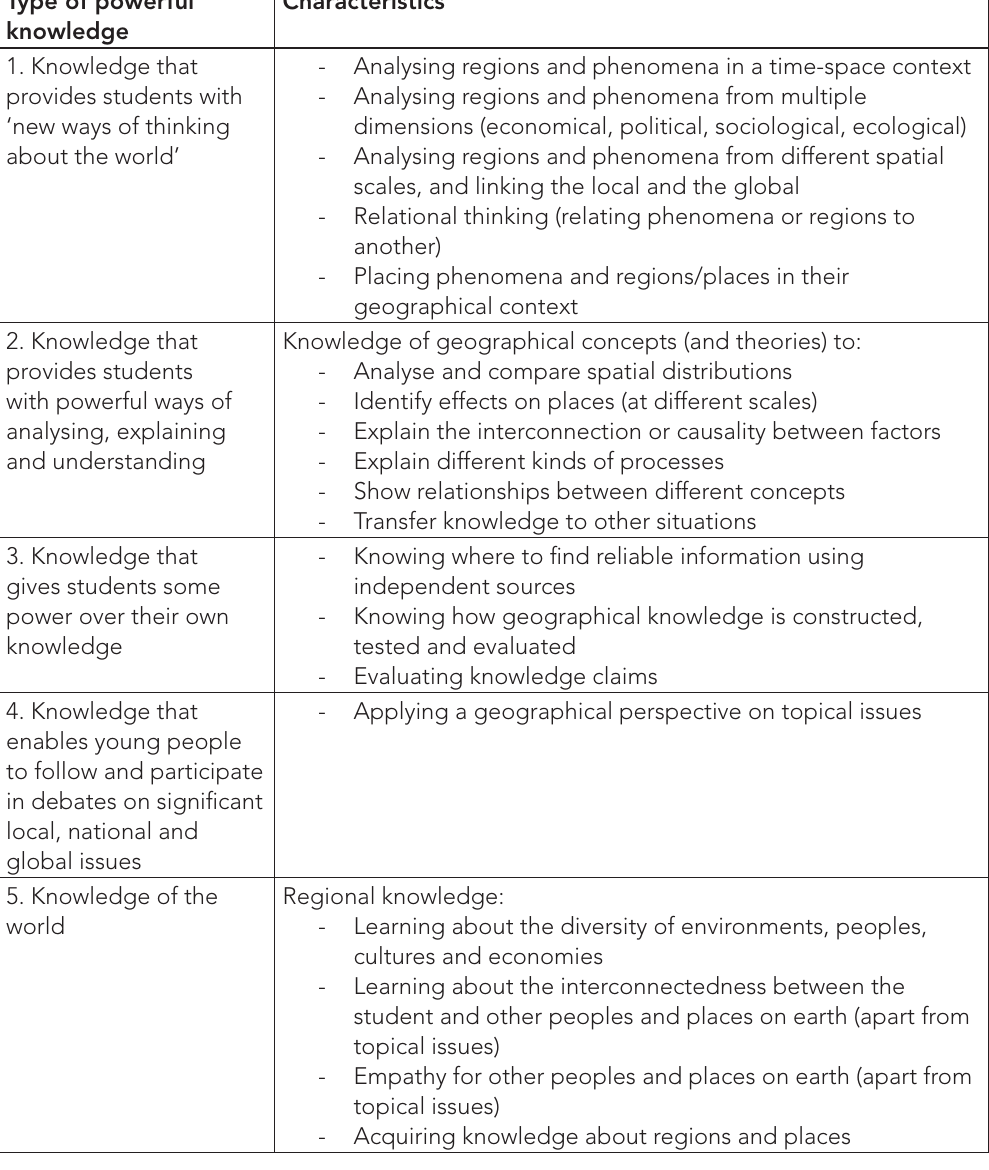
Table 2: Adaptation of the characterization of powerful knowledge by Maude (2015) Type of powerful